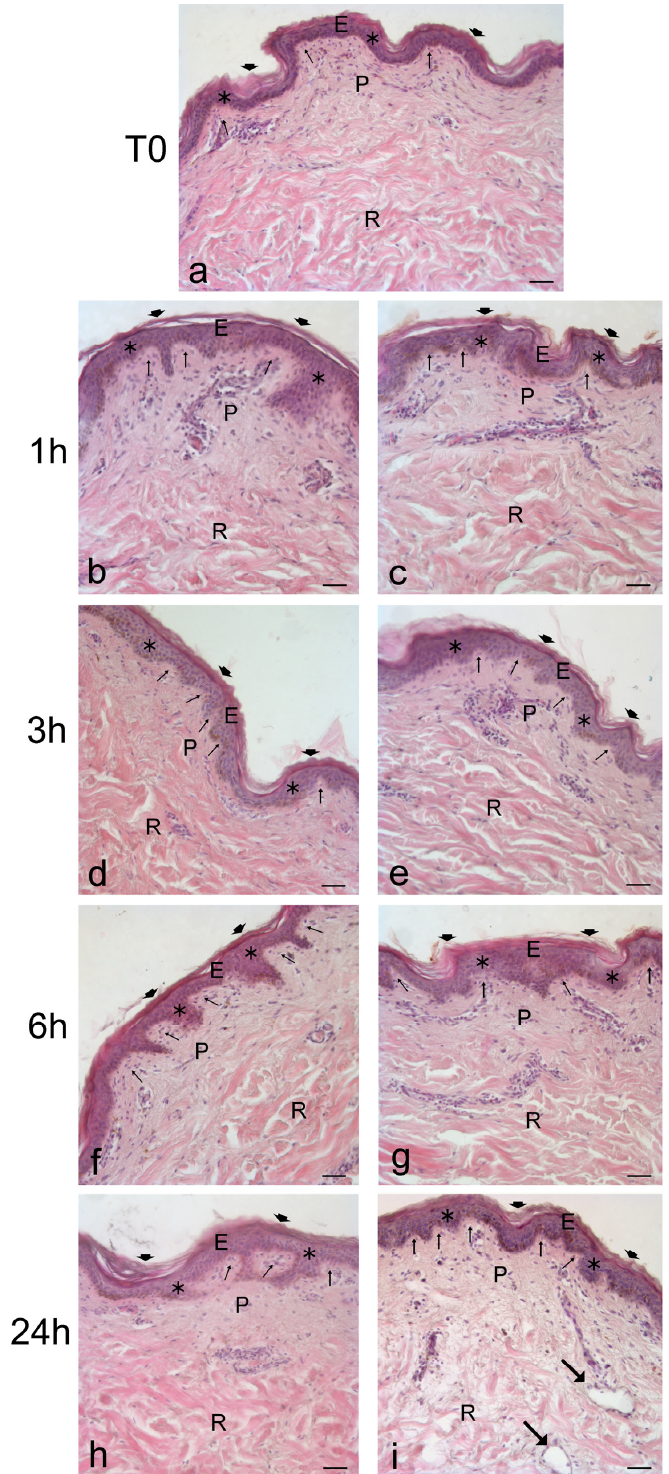
Figure 3. Bright-field microscopy images of human skin samples at T0 ( a ) and after 1 h ( b , c ), 3 h ( d , e ), 6 h ( f , g ) and 24 h ( h , i ) in the bioreactor in the presence of dithranol ( c , e , g , i ) or without dithranol as controls) ( b , d , f , h ). E, epidermis; P, papillary dermis; R, reticular dermis. In the epidermis, arrowheads indicate the corneocytes’ layer, asterisks indicate the keratinocytes’ layers and small arrows the dermal papillae. Note the dilated capillaries in ( i ) (arrows). Bars: 50 µ